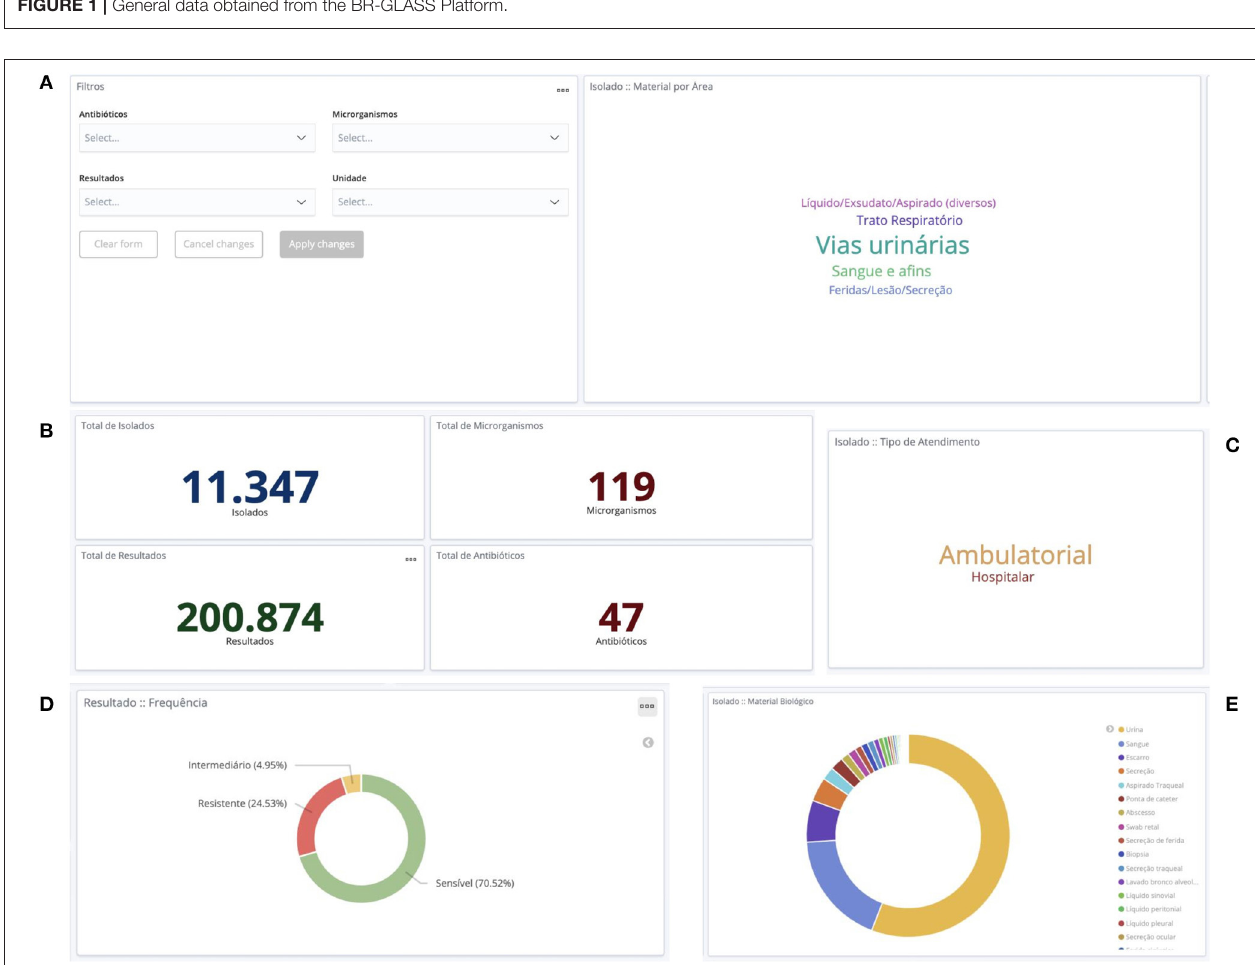
FIGURE 2 | Opening dashboards of the BR-GLASS platform. (A) Left: System’s Filters for antibiotics, microorganisms, results (susceptible, intermediate or resistant) and Ward; Right: Word Cloud for isolates by anatomical site. (B) Total isolates (year 2018), different species, total results and total kind of antibiotics tested. (C) Word Cloud for outpatients (Ambulatorial) and inpatients (Hospitalar). (D) Total frequency of susceptible, resistant and intermediate isolates. (E) Percentage of samples by sample